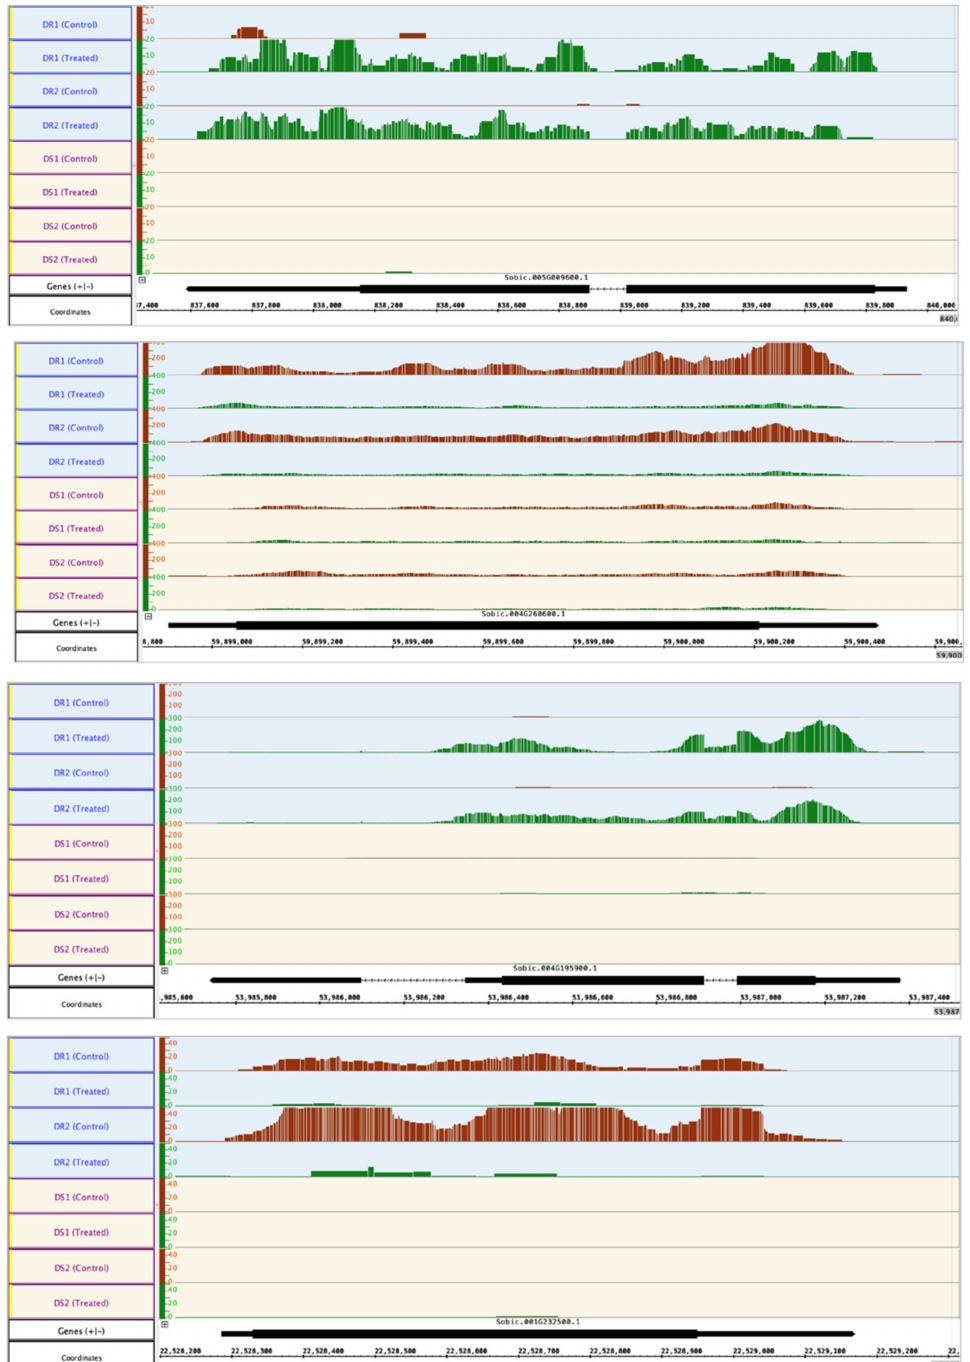
Figure 4. Relative sequence read abundance (Integrated Genome Browser view) as histograms of di ff erentially expressed genes only in the drought-resistant (DR1 and DR2) genotypes. Top two panels) One up-regulated (top) and one down-regulated gene (bottom) in resistant genotypes (DR1 and DR2) after 1-hr PEG-treatment. Replicates of each line are shown. Bottom two panels) One up-regulated (top) and one down-regulated gene (bottom) in resistant genotypes (DR1 and DR2) after 6-hr PEG-treatment. Replicates of each line are shown. The Y-axis indicates the read count. Gene structure and gene ID are shown below the read tracks. In the gene structure, lines represent introns and the boxes represent exons. The thinner boxes represent 5 (cid:48) and 3 (cid:48)